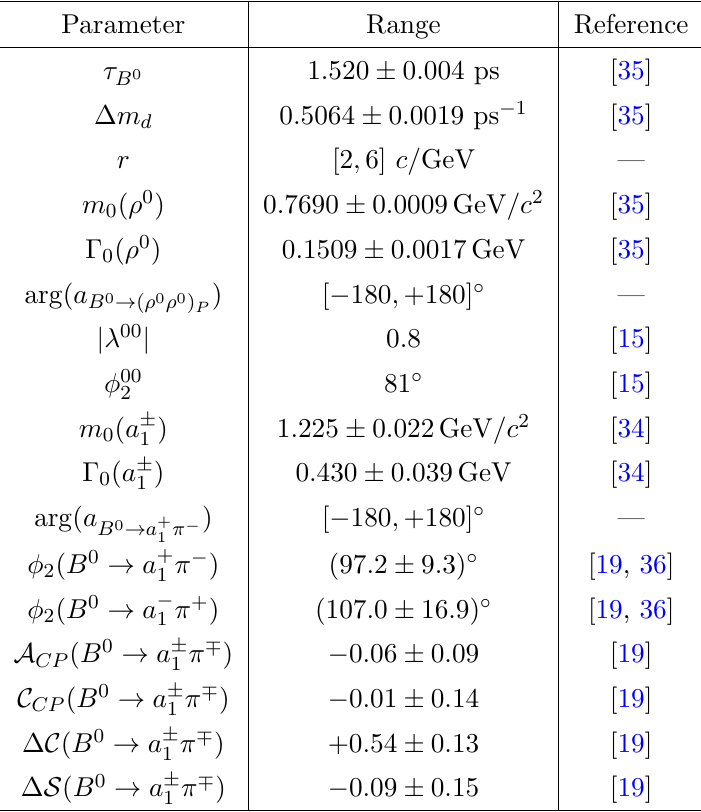
Table 1 . Stage 1 parameters. Uncertainties indicate the parameter was Gaussian distributed, square brackets indicate uniform generation within the range while a single value is a constant of